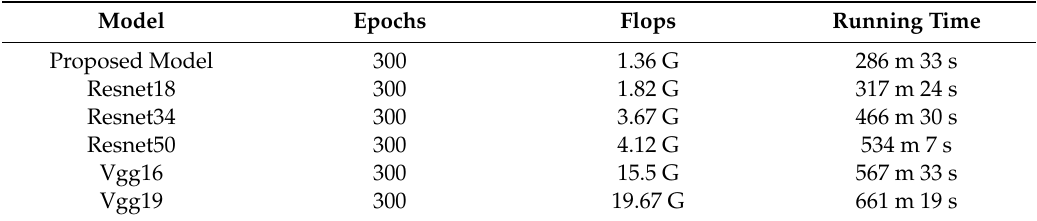
Table 7. Model computational e ffi ciency and computational complexity